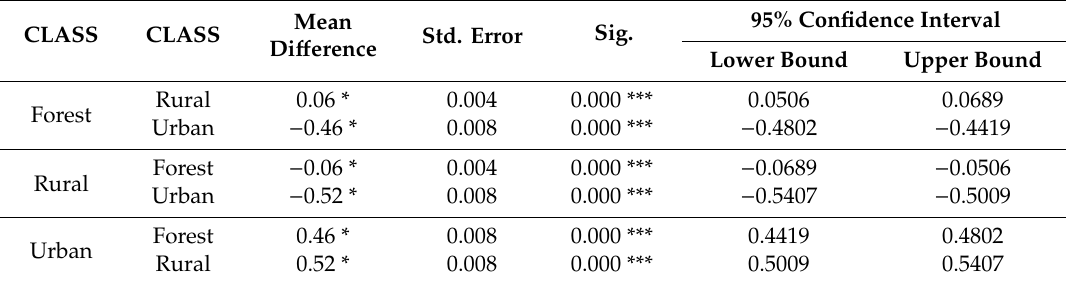
Table 4. The one-way ANOVA table shows the difference of mean air temperature anomaly among the three land-use types (urban, rural, forest). Table 5. The results of Tukey’s HSD(honestly significant di ff erence) post hoc test. Std. error: Standard error, Sig.: Significance value.